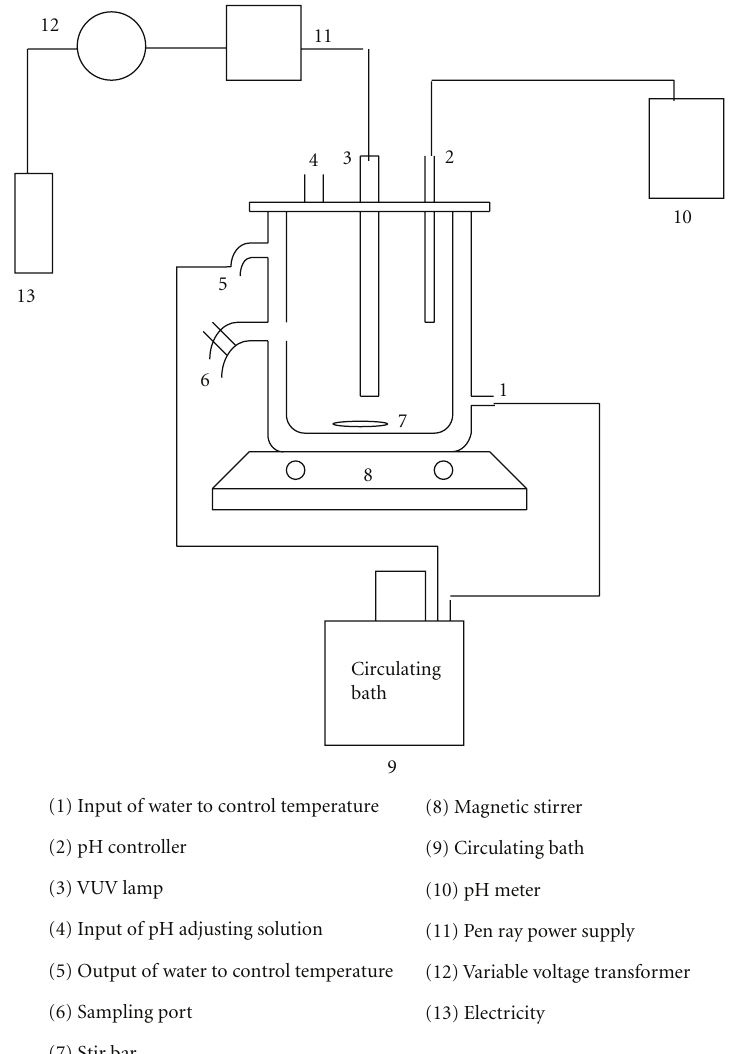
Figure 2: The schematic diagram of the reactor